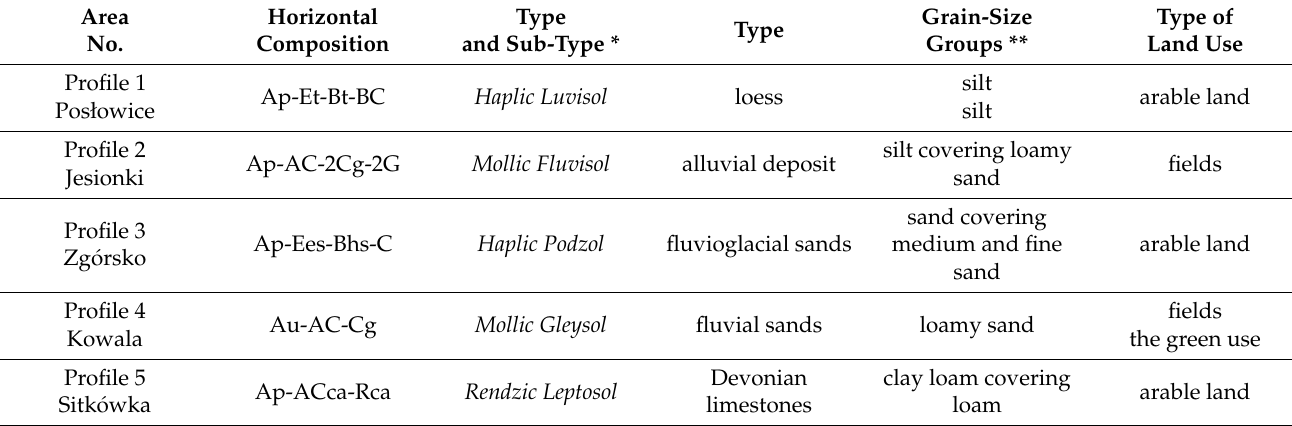
Table 2. Profile structure and general characteristics of soils (* names of soils and sequences of horizons are given according to the Systematics of Polish Soils from 2011 and (World Reference Base for Soil Resources) WRB 2006, ** Grain size groups, according to the United States Department of Agriculture (USDA) and (Soil Science Society of Poland) PTG 2008).